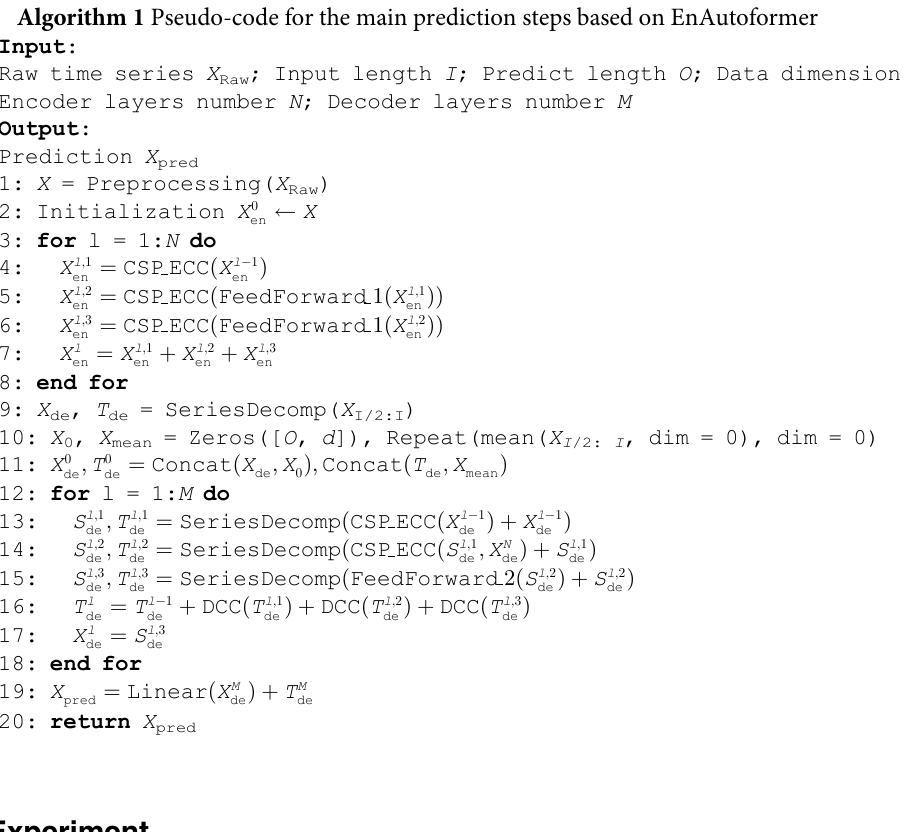
Algorithm 1 Pseudo-code for the main prediction steps based on